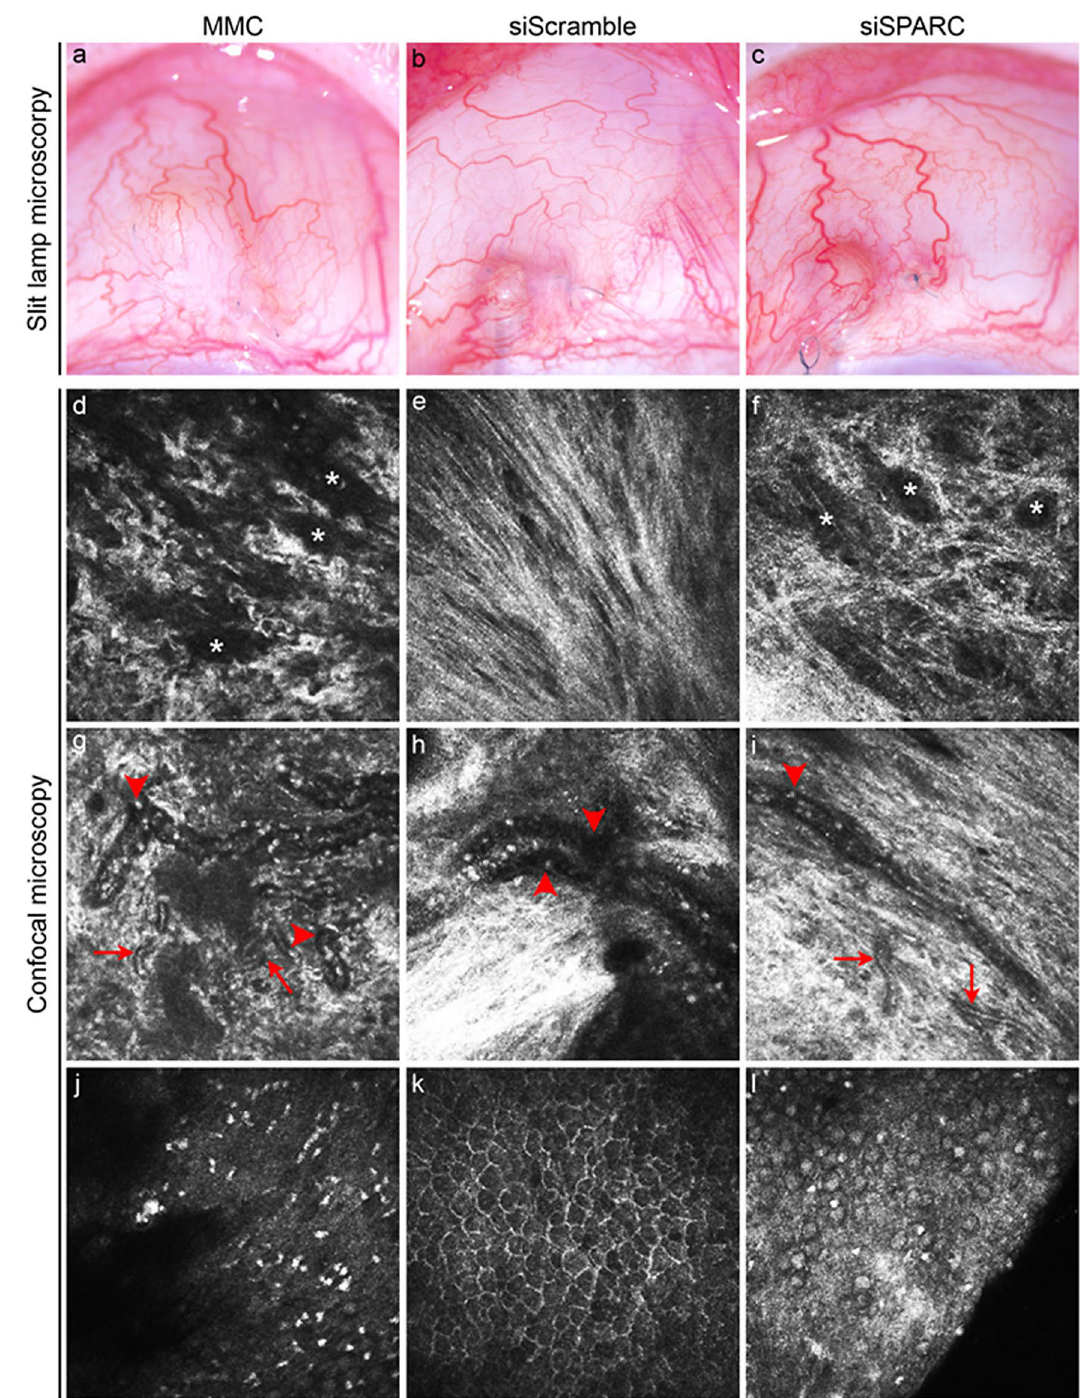
Figure 5. Live imaging of operated tissues in a rabbit model of glaucoma filtration surgery with insertion of a 24-gauge cannula . ( a – c ) Slit-lamp microscopy of the week 4 postoperative tissues treated with MMC, or hydrogel incorporated with scrambled or SPARC siRNAs. While blebs were no longer visible in all the MMC or siScramble-hydrogel treated tissues, 4 of 5 siSPARC-hydrogel treated tissues maintained visible blebs at week 4. ( d – l ) In vivo confocal images of the week 4 operated area. *, microcysts; red arrowheads, large vasculature; red arrows, fine